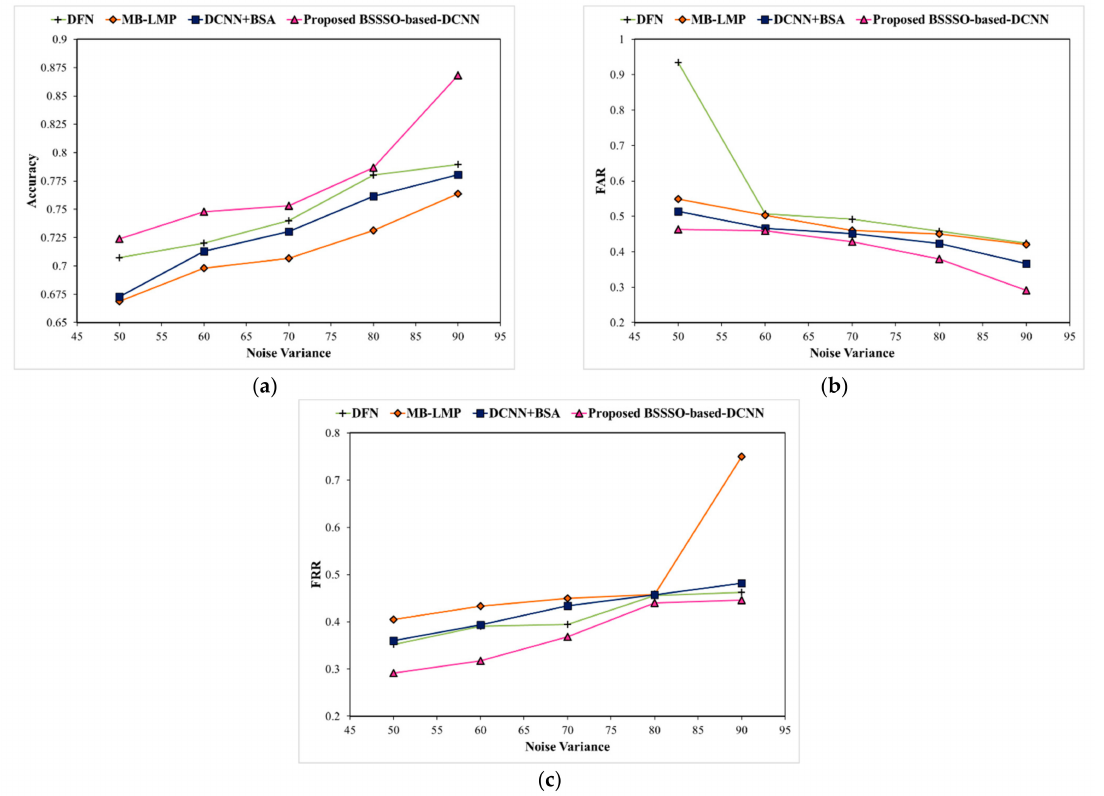
Figure 8. Analysis based on LFW dataset by varying the noise variance.